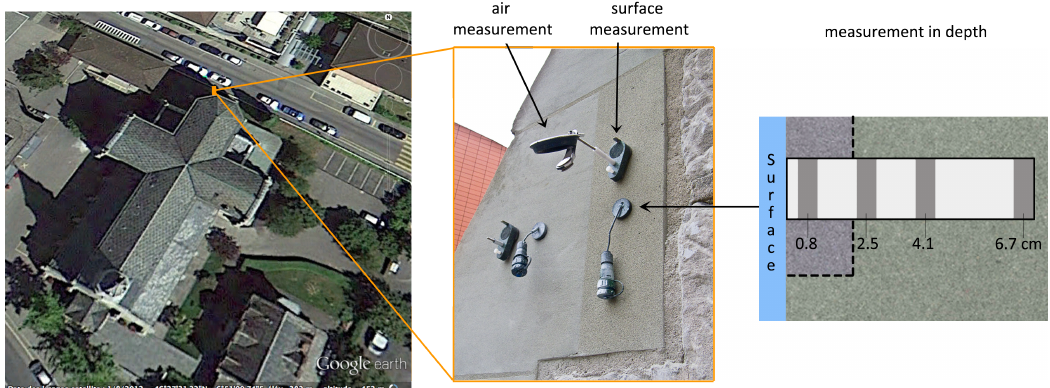
Figure 5. The church where the sensors have been applied in Vevey, and a close view of the